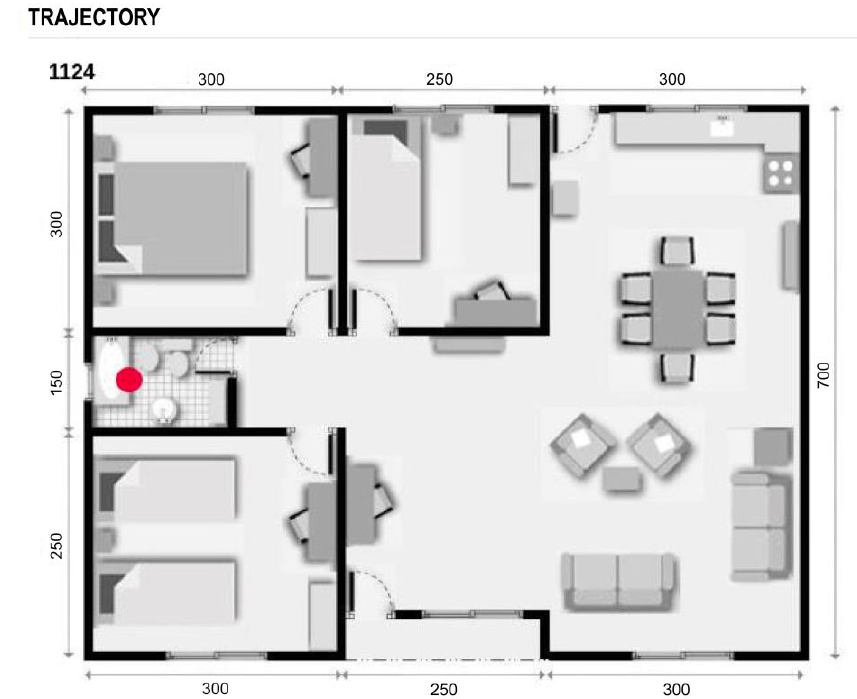
Figure 6. Representation of the location of the older adult at a given time.